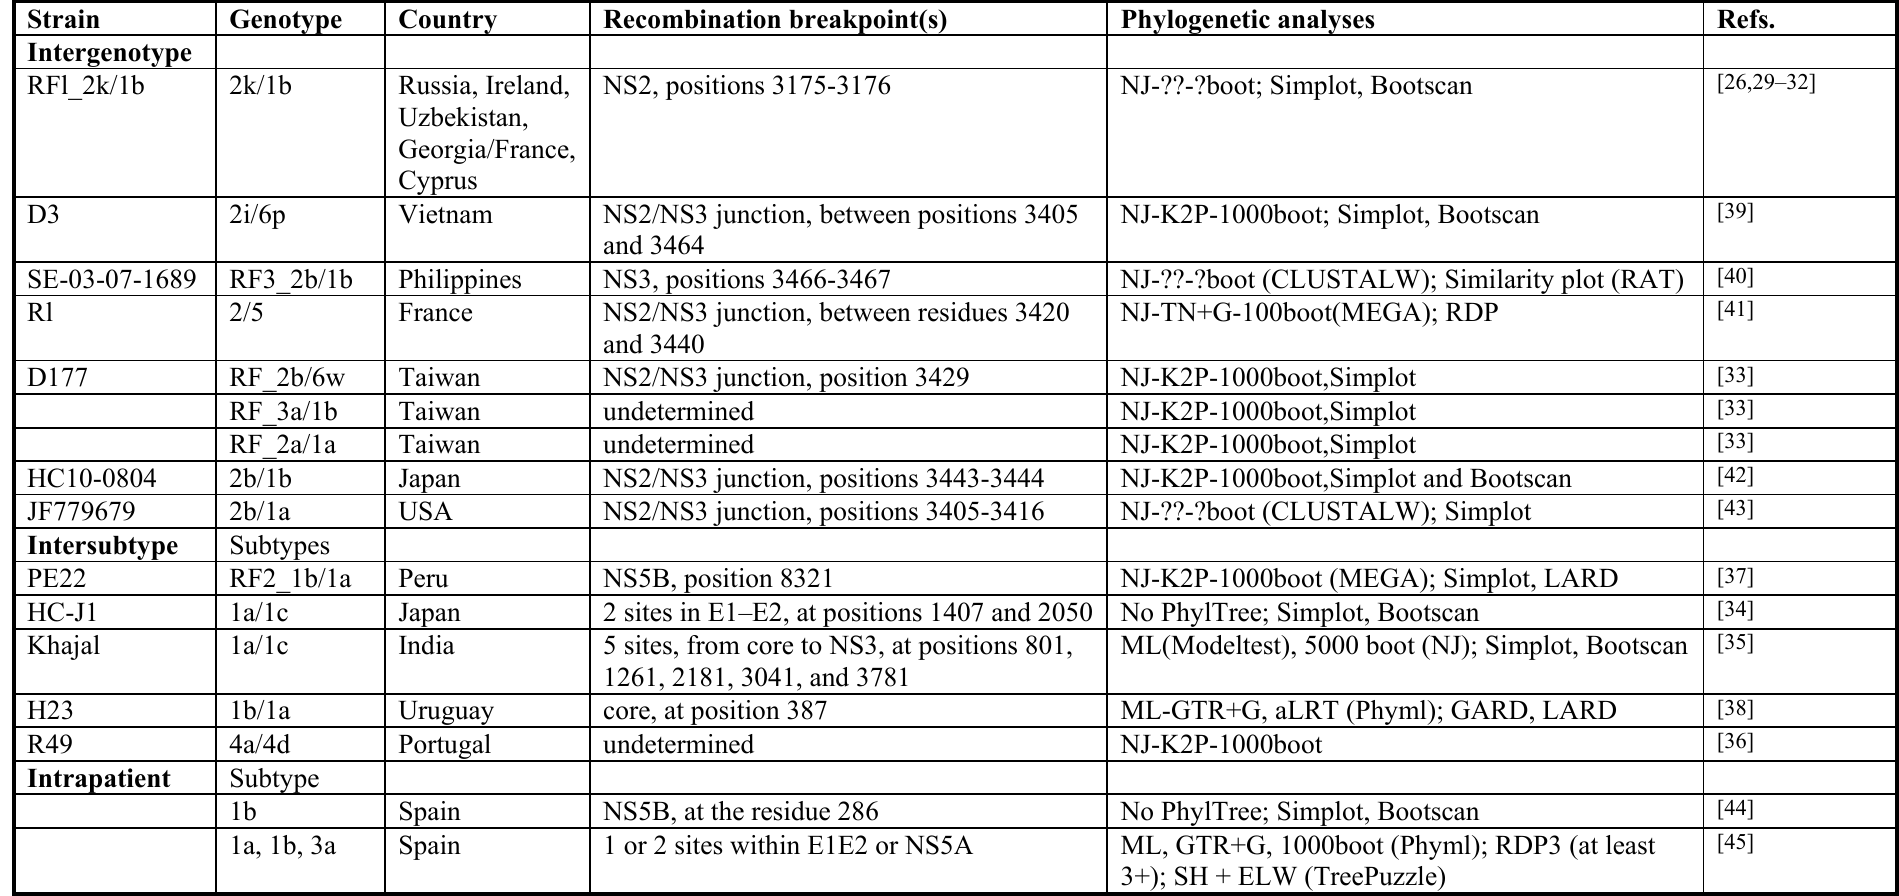
Table 1. Summary and main features of the published cases of recombination in Hepatitis C virus (HCV). The phylogenetic analyses column summarizes the method used for inferring the phylogenetic trees (NJ: neighbor-joining, ML: maximum likelihood), along with the evolutionary model (K2P: Kimura 2 parameter, TN: Tamura-Nei; GTR: general time reversible, G: gamma distribution for heterogeneity among sites), method for evaluating branch support (boot: bootstrap resampling with number of pseudorandom replicates, aLRT: approximate likelihood ratio test), and method or software used for testing and/or identifying recombination